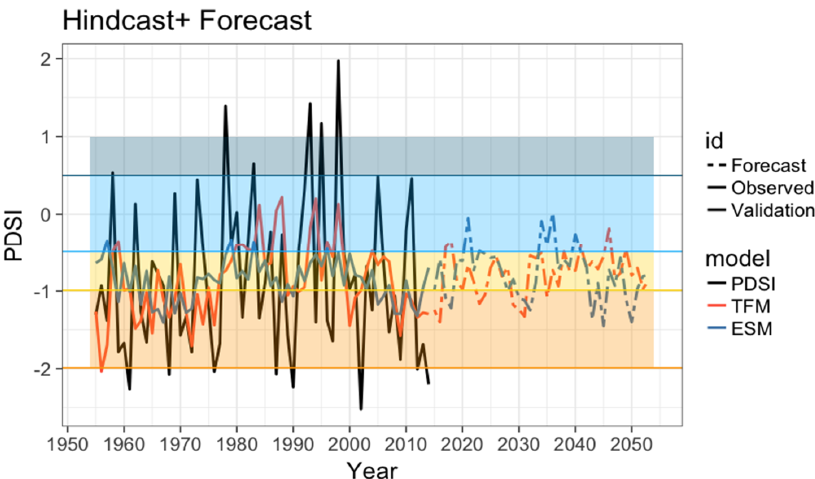
Figure 14. Comparison between estimates from the exponential smoothing model (ESM) and the Transfer Function model (TFM) for both the validation period (1954–2014) and the forecast